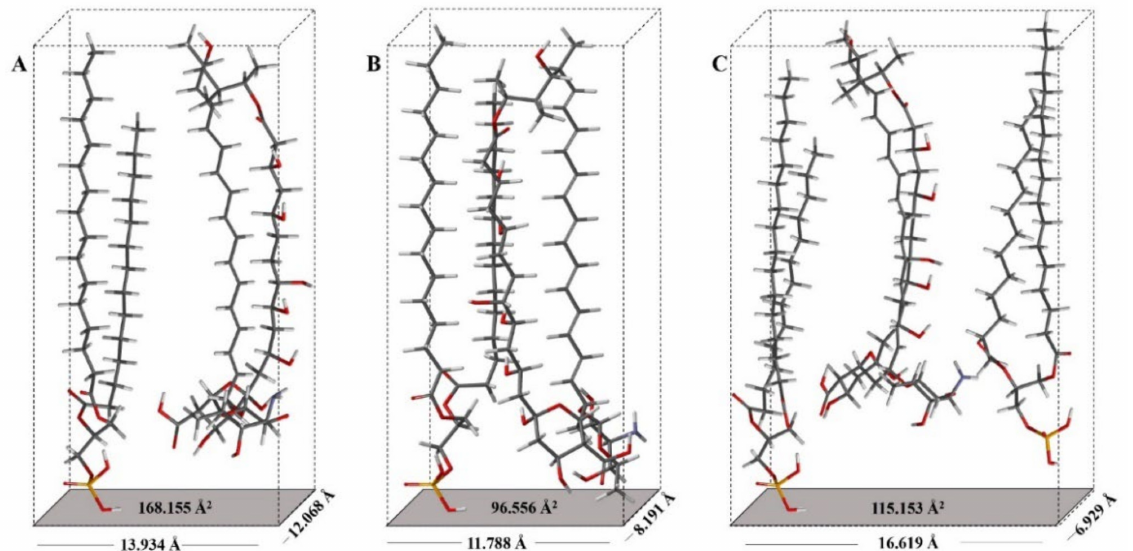
Figure 8. Orientation model of the AmB molecule with lipids extracts of the external surface of the cell wall of mycelial phase of H. capsulatum : ( A ) Environmental isolate in vertical position (A v ); ( B ) Environmental isolate in horizontal position (A h ). ( C ) Clinical isolate in horizontal position (A h ). The AmB + clinical lipid extract mixture produced a surface pressure of 11.4 mN/m, which is 2.8 mN/m less than that generated with the environmental lipid extract.